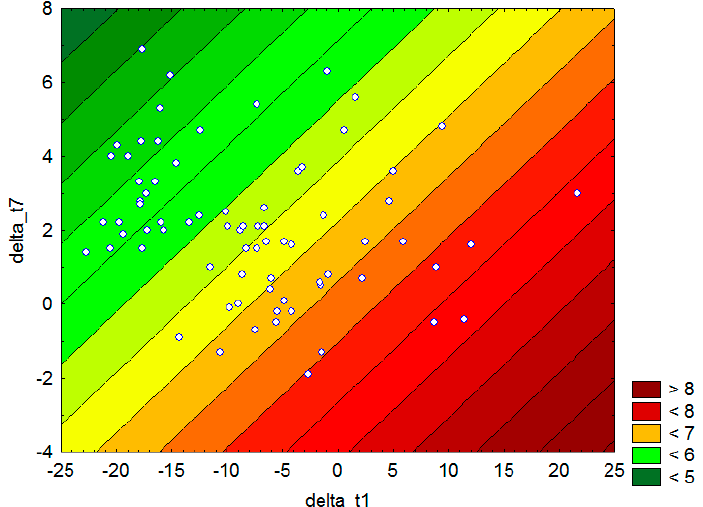
Figure 7. The dependence of a j -provenance seed mass on the differences of the July ( ∆ T 7 ) and January temperatures ( ∆ T 1 ) in the i -th year for 1999–2003 and 2010 (a year of seed measurements in the test site) and the multi-year T 1 and T 7 means of j -provenance, respectively.